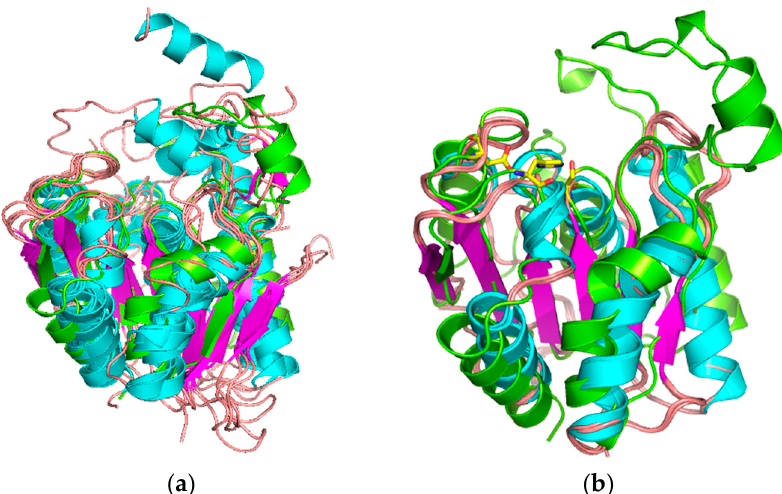
Figure 2. Structural comparison of model LvFSH. α / β -hydrolase models were obtained from the MSD server (http://www.ebi.ac.uk/msd-srv/ssm/); ( a ) esterase structures (root mean square deviation (RMSD) 2.24 Å, Q-score 0.2836 for 137 C α ); ( b ) lipase structures (RMSD 1.127 Å, Q-score 0.4678 for 149 C α ). The LvFSH model is shown in green.